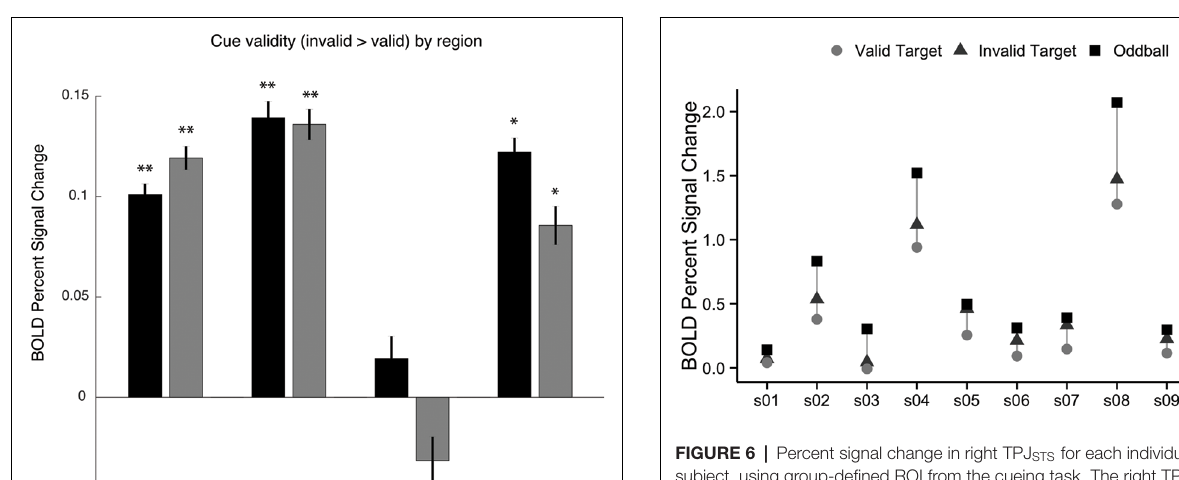
TPJ with the localization method color-coded. Note that all of these studies are group averages. We compare this